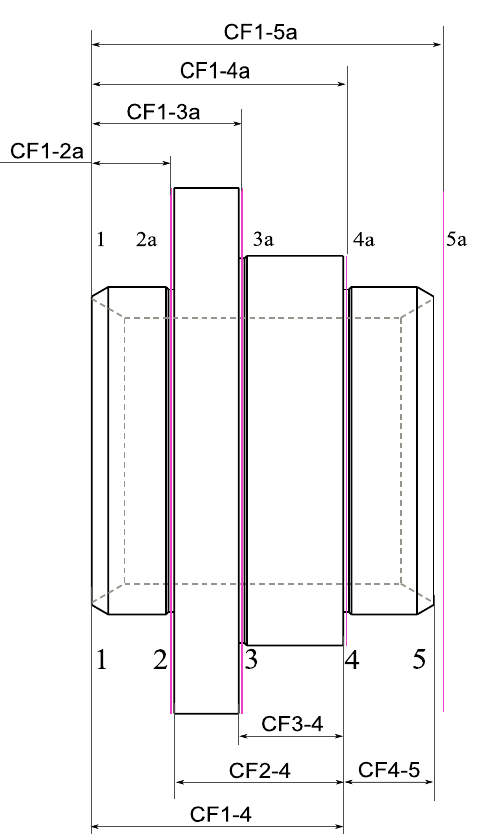
Fig. 4. Representation of the pilot